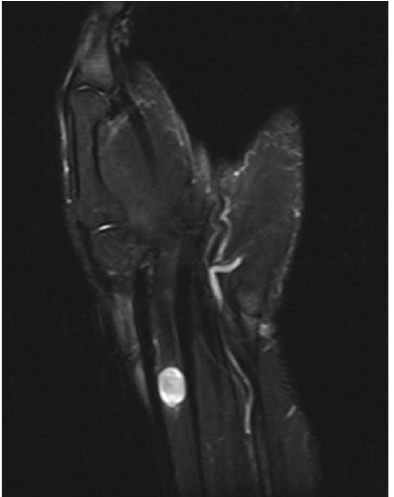
Figure 3: Intraoperative view of the lesion showing that the mass at the wrist was originated from the median nerve.